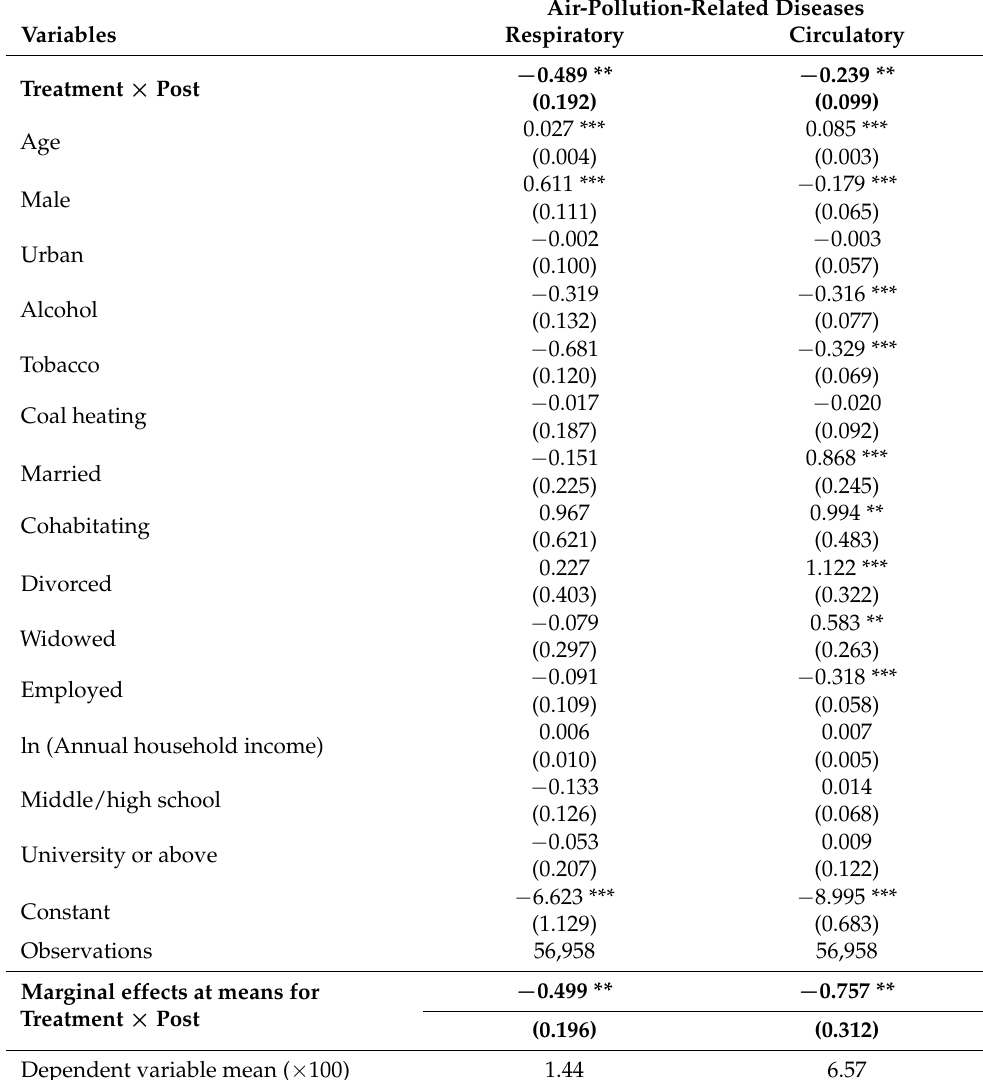
Table 3. Logit estimates: effects of the APPCAP on chronic